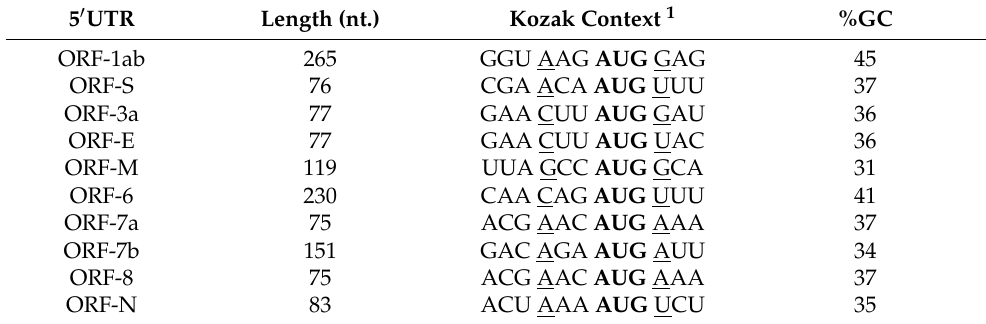
Table 1. Length, Kozak context and %GC of the SARS-CoV-2 gRNA and sgRNA 5 (cid:48) UTRs. 5 (cid:48) UTR